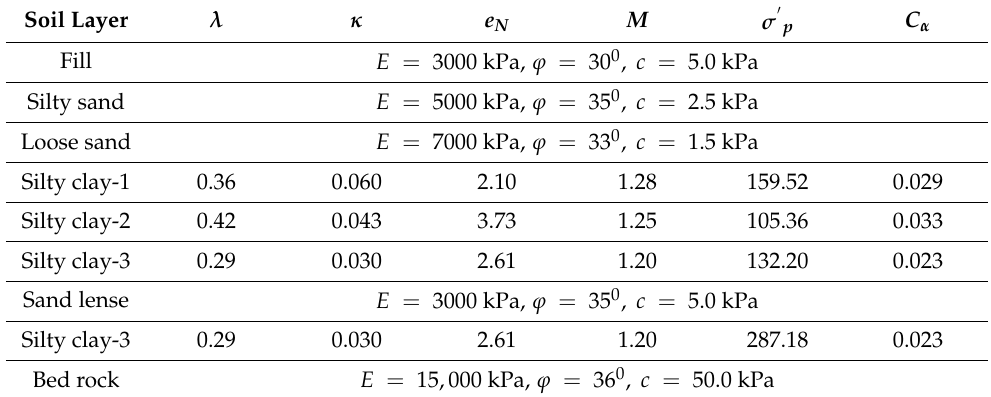
Table 2. Finite element model parameters of the NBR embankment (Islam and Gnanendran [8]). Soil Layer λ κ e N M σ (cid:48) p C α